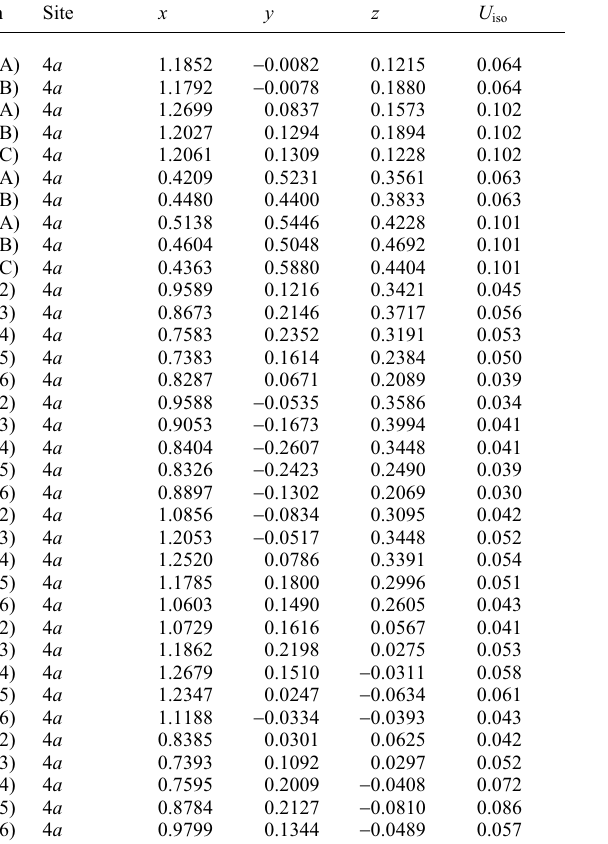
Table 2. Atomic coordinates and displacement parameters (in Å 2 ) .